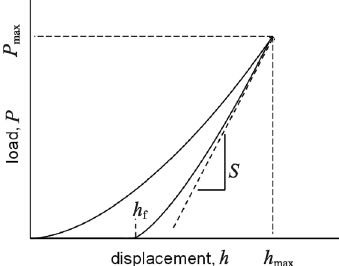
Fig. 3 Force displacement curve of a typical nanoin- dentation experiment.